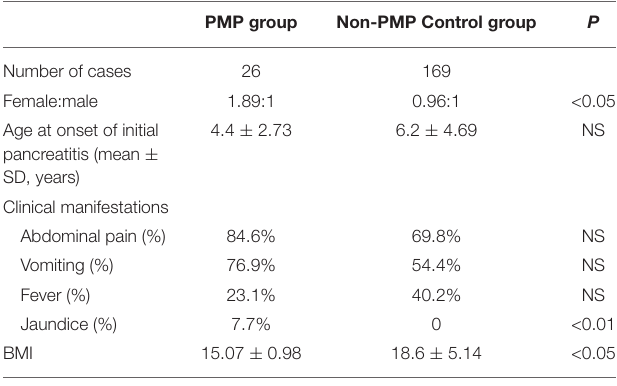
TABLE 2 | Differences in laboratory indicators between the PMP and the non-PMP groups.